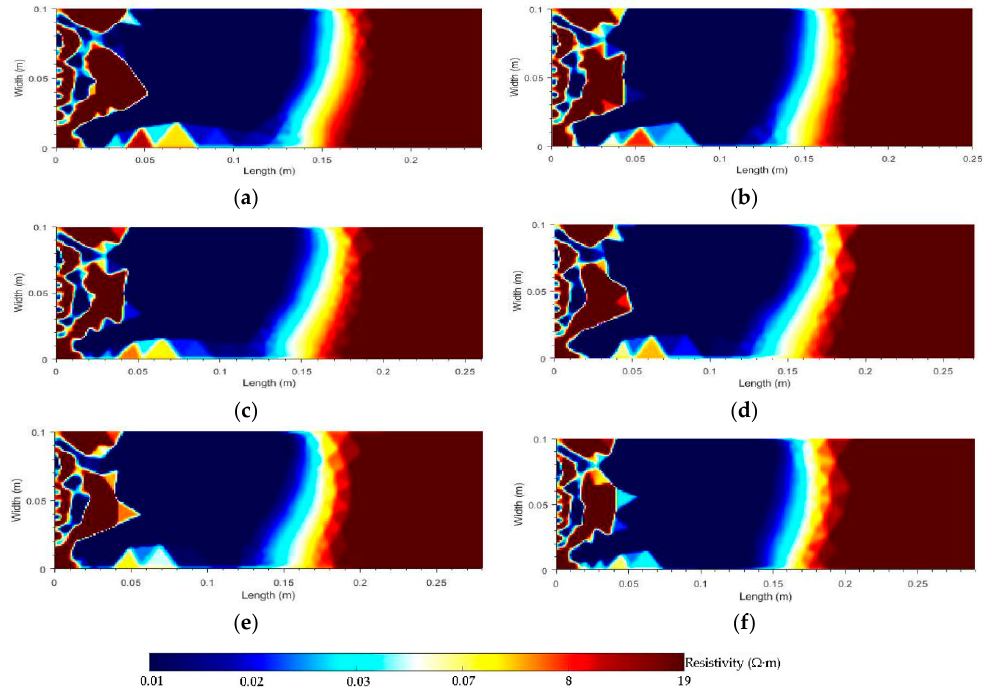
Figure 9. Inversion results of virtual grounding electrode at di ff erent distances when L = 0.15 m and I 0 = I 1 = 1 mA. ( a ) Is the inversion result when D = 0.24 m; ( b ) is the inversion result when D = 0.25 m; ( c ) is the inversion result when D = 0.26 m; ( d ) is the inversion result when D = 0.27 m; ( e ) is the inversion result when D = 0.28 m; ( f ) is the inversion result when D = 0.29